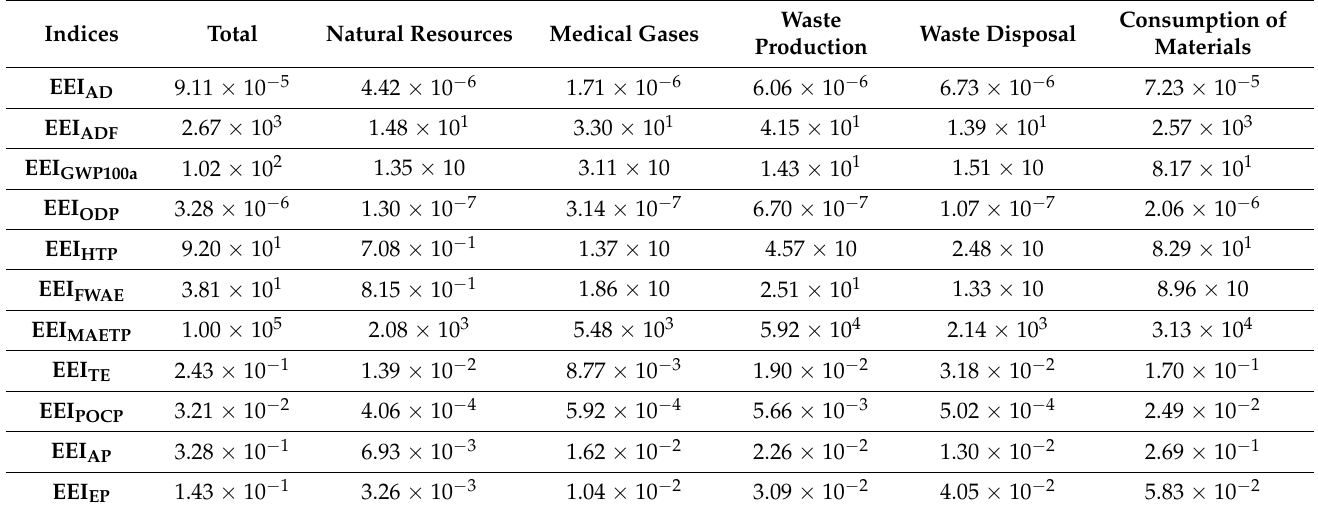
Table 7. Hospital activity environmental efficiency indices of the activities and services provided by the hospital in 2019 classified by impact category.